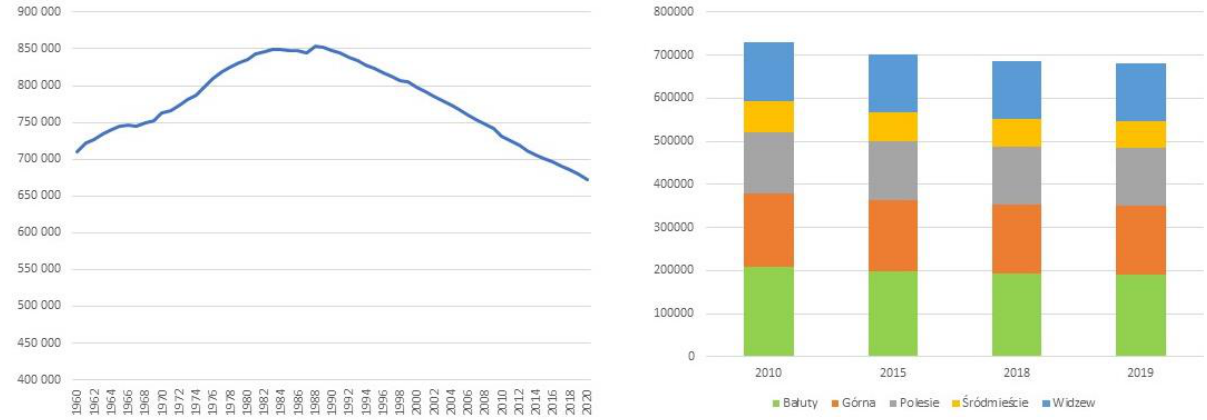
Fig. 3. Population of Łódź and its districts between the years 1960-2020 (Source: Own study based on the Statistical Yearbooks, LDB and Łódź Voivodeship Statistical